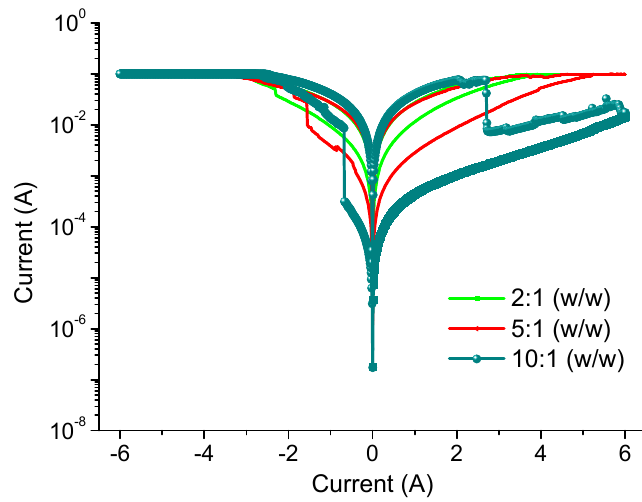
Figure 3. I - V curves of ITO/PBD:GO/Ni with weight ratio of the composite 2:1, 5:1, and Figure 3. I ‐ V curves of ITO/PBD:GO/Ni with weight ratio of the composite 2:1, 5:1, and 10:1.